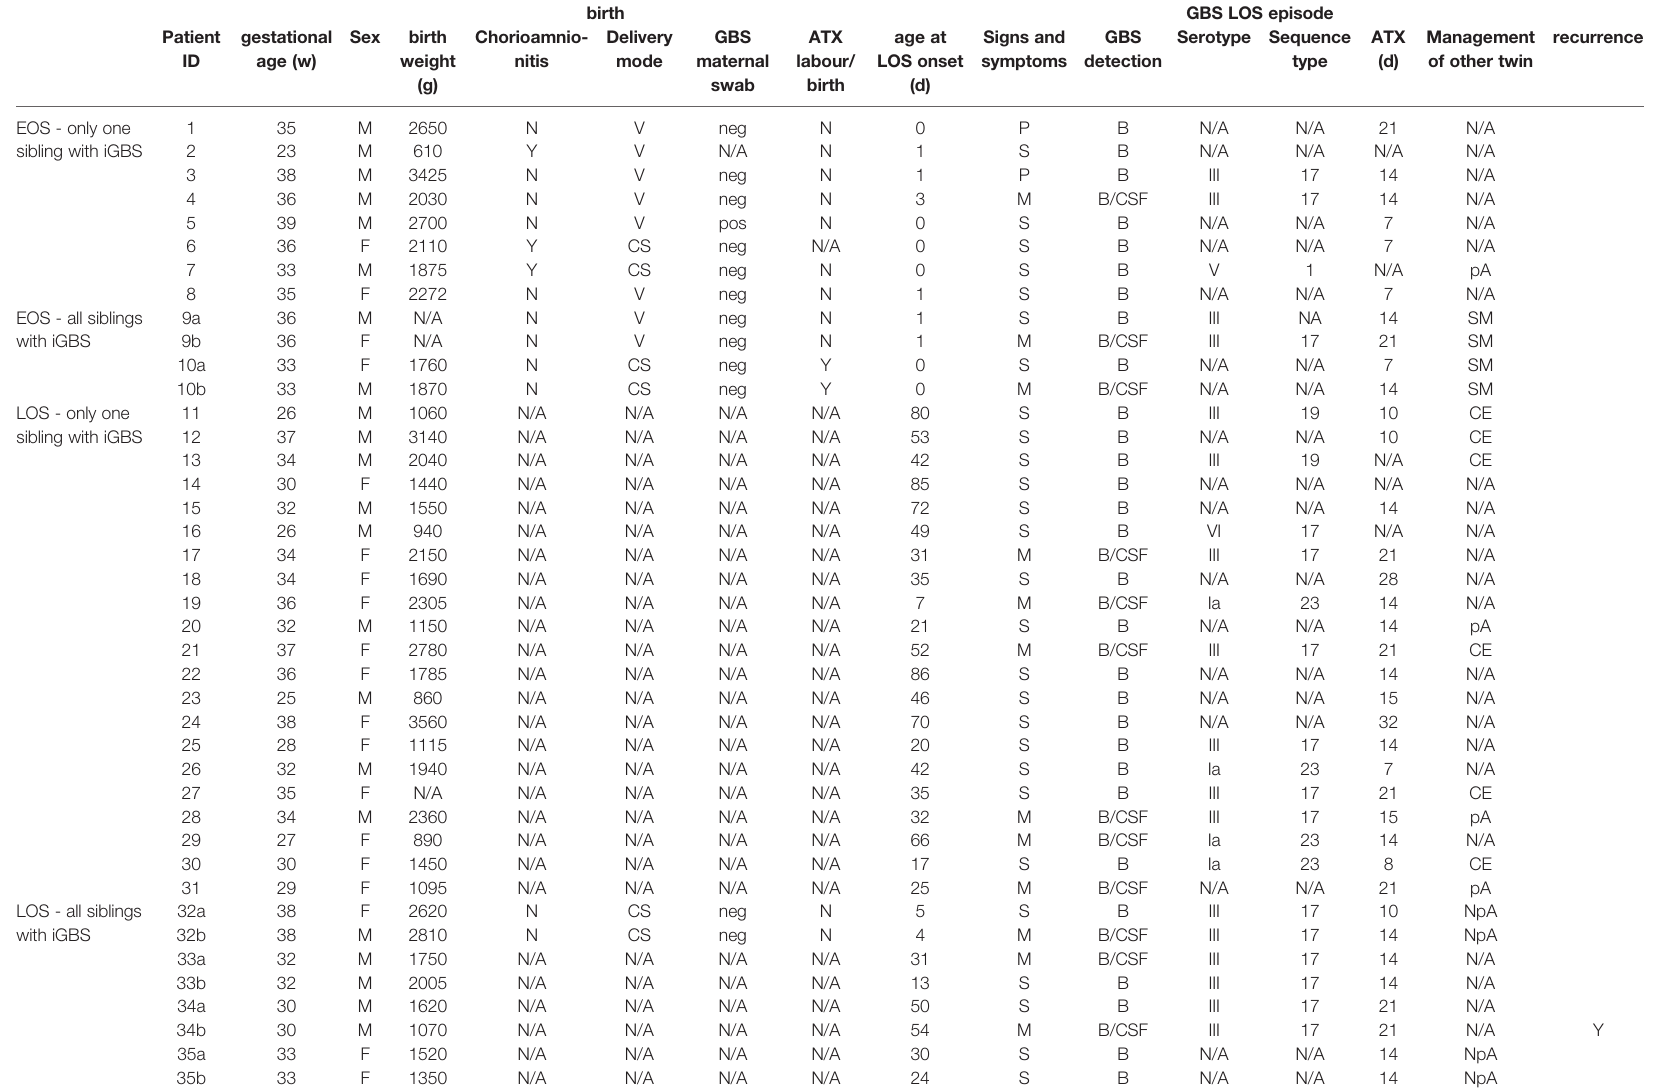
TABLE 1A | Clinical features of GBS infections in infants from multiple births